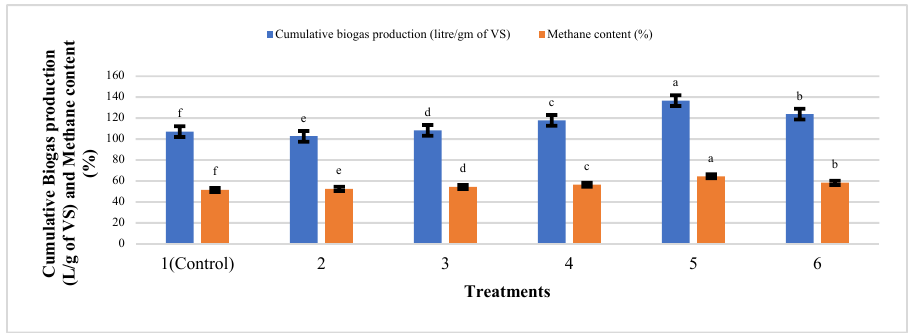
Figure 8. Cumulative biogas and methane production from cattle manure supplemented with different concentrations of IONPs. Bars with different letters depict significantly different values at p ≤ 0.05.